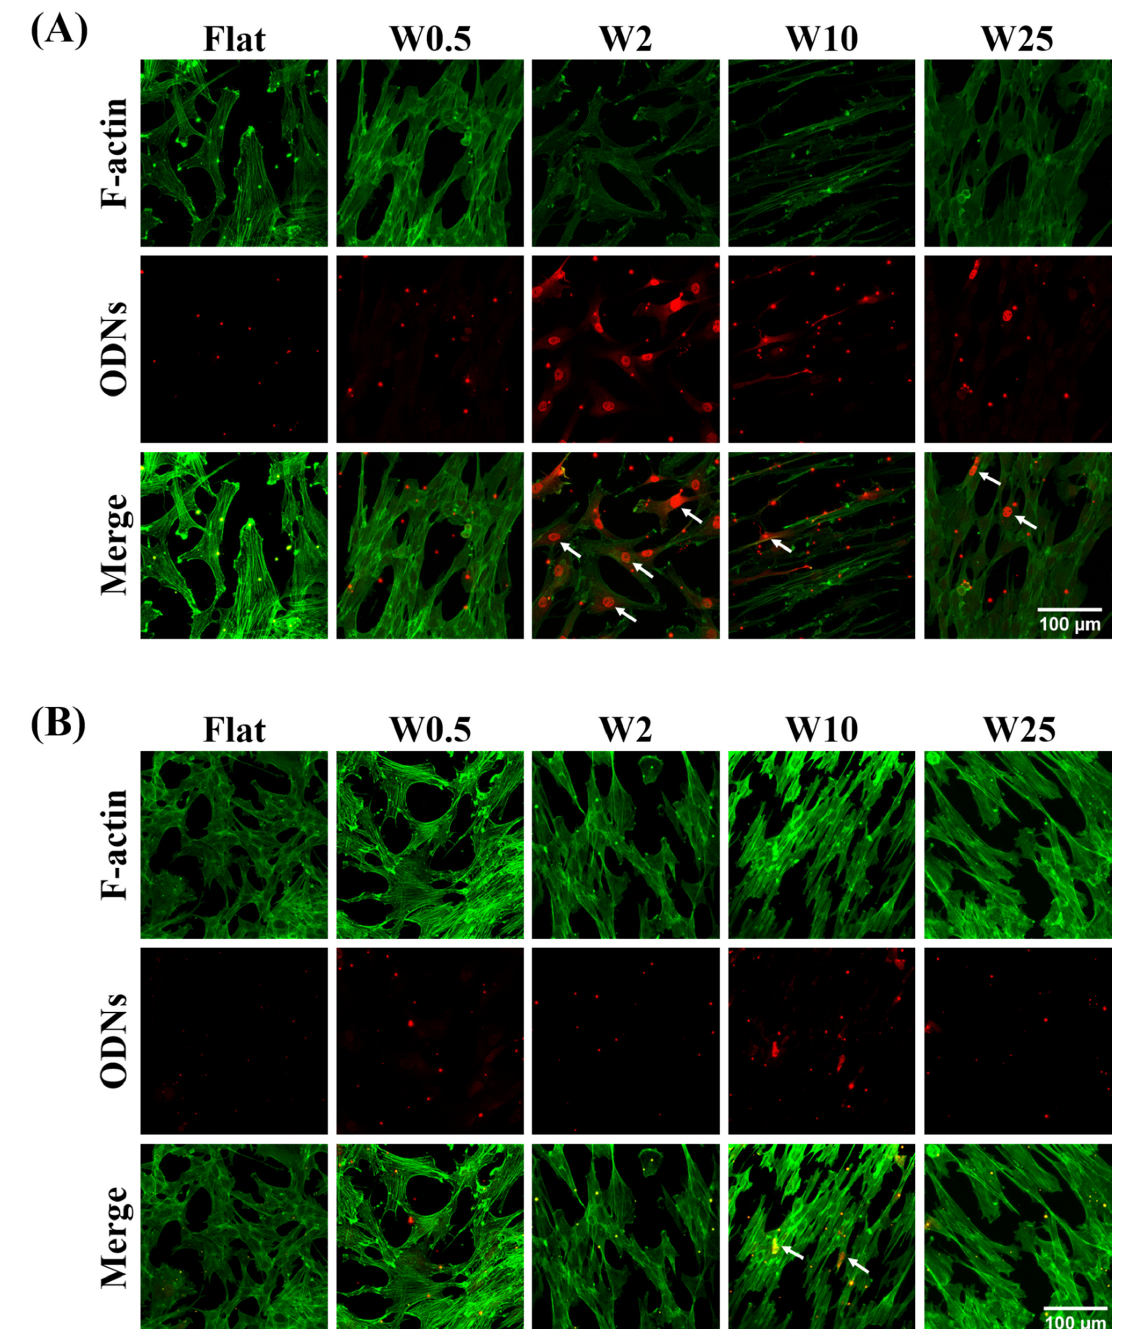
Figure 5. Influence of nano- and micropatterns on the cellular uptake capacity of cationic complexes. ( A ) Representative fluorescence images of hBM-MSCs cells cultured on wave-like PDMS, showing the cellular uptake of oligonucleotides (red). F-actin was stained with FITC-labeled phalloidin (green). ( B ) Representative fluorescence images of myoblast cells cultured on wave-like PDMS showing cellular uptake of oligonucleotides (red). F-actin was stained with FITC-labeled phalloidin (green). Scale bar is 100 µ m and applies to all images. White arrows mark positive